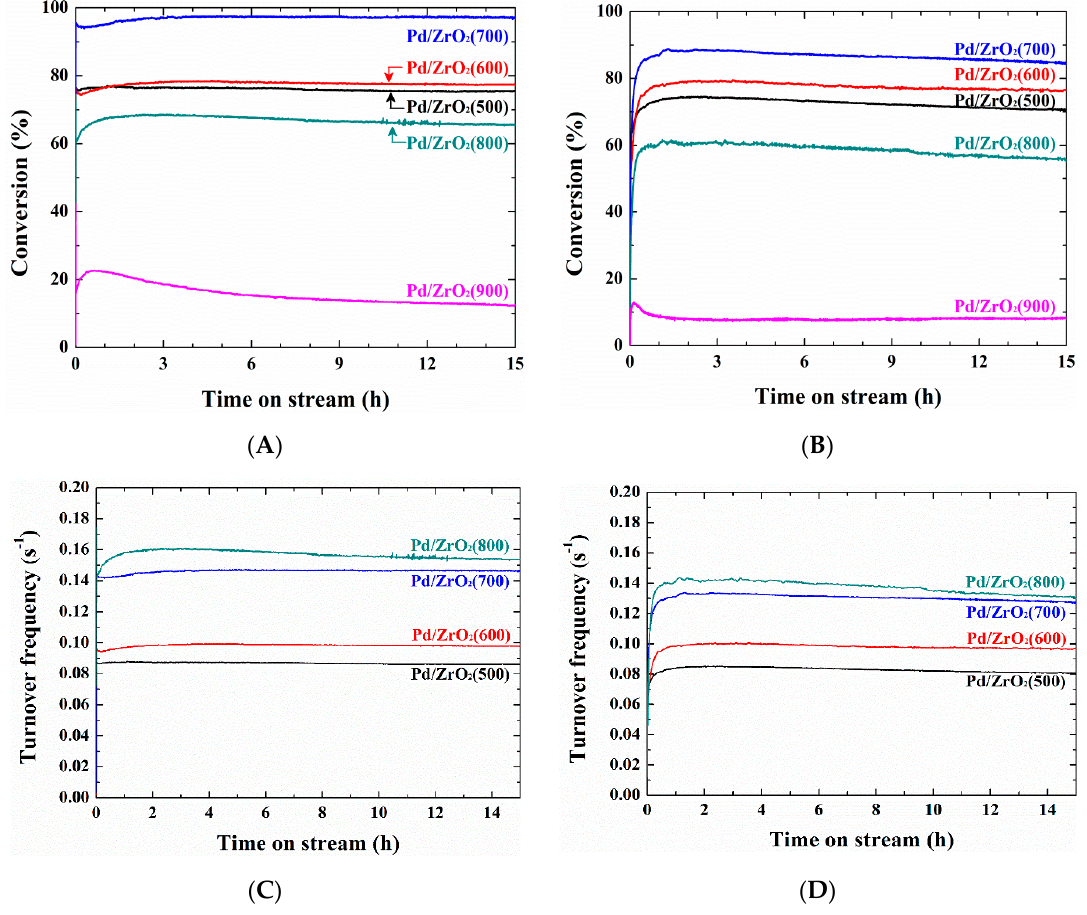
Figure 7. Isothermal reactions over the Pd / ZrO 2 (x) catalysts: ( A ) conversion and ( C ) turnover frequency (TOF) in the absence of water vapor at 400 ◦ C, and ( B ) conversion and ( D ) TOF in the presence of 10 vol% water vapor at 450 ◦ C. The total flow rate was fixed at 400 cm 3 / min (GHSV = 240,000 cm 3 g cat − 1 h − 1 ).